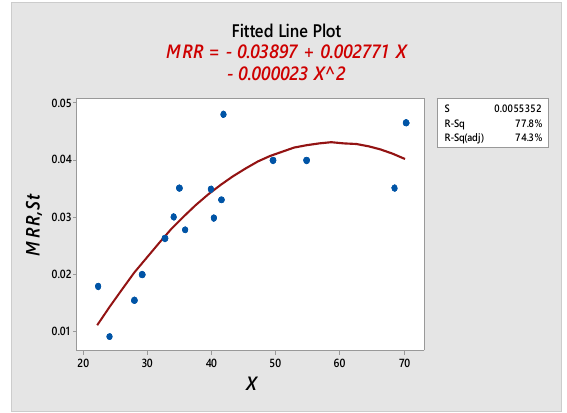
Fig.6. The relationship between the temperature and MRR of